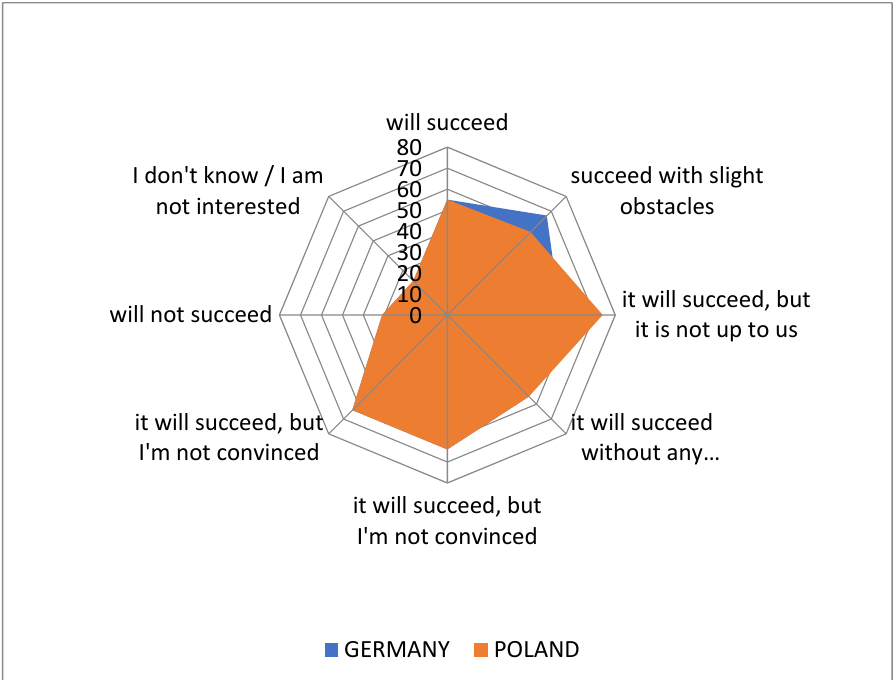
Figure 24. Opinion of people who run businesses and are married at the same time. The opinion of people running a business and being married at the same time clearly indicate success in Poland. On the other hand, in Germany, about 18% are much lower in